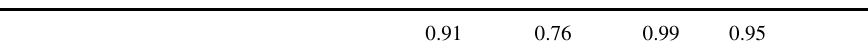
Fig. 2 The standard curve related to the different concentrations of curcumin has a correlation coef fi cient of R2 as 0.96 guarantying the speci fi city of 425 nm for curcumin ( a ). The release pattern of the free Table 3 The regression coef fi cients belonged to the different kinetic models of the curcumin release from the curcumin niosome